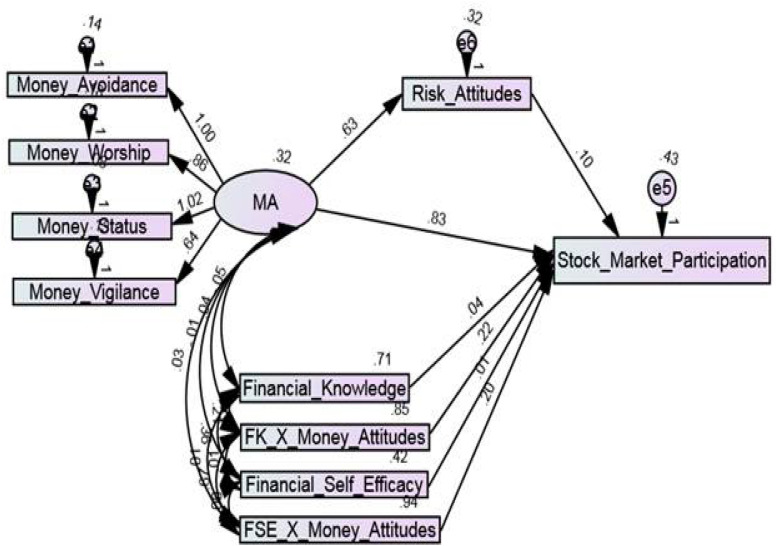
Structural model.